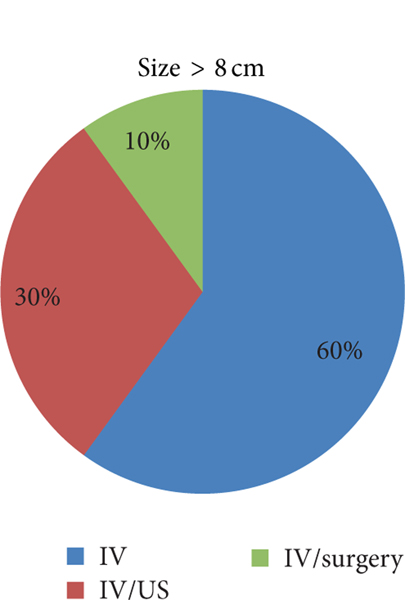
Percentage of each treatment modality used for TOA measuring >8 cm.